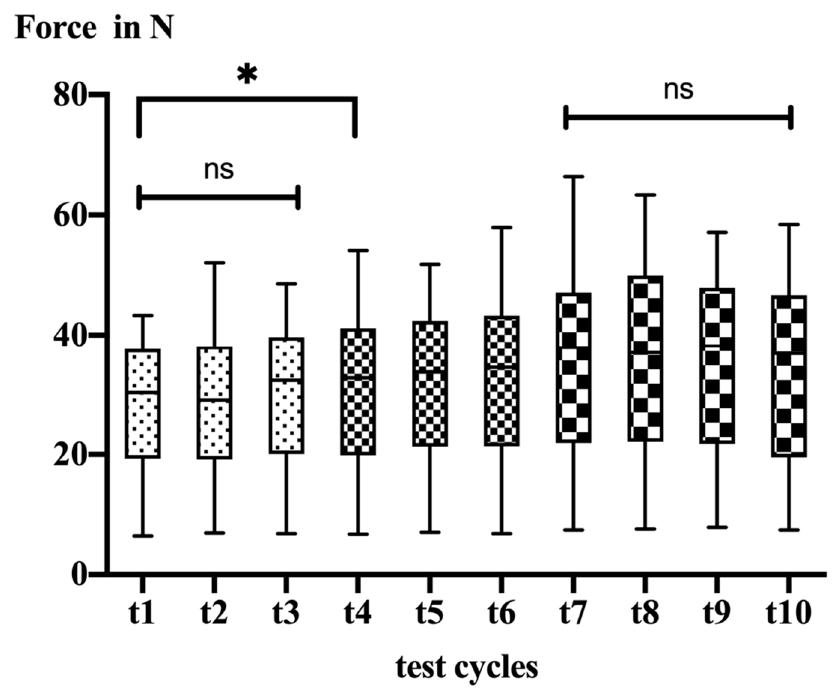
Figure 3. Box plots illustrating data of all test cycles for 12 mm lateralization; ns = not significant, * = significant